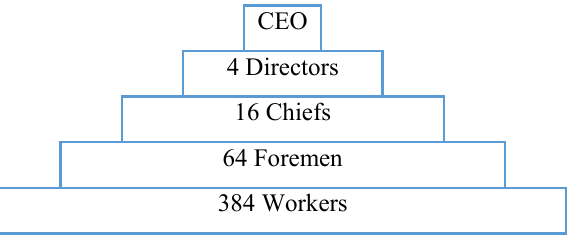
Figure 5: Example of an organization's hierarchical structure In this example, the total number of base workers ( T ) in the organization is 384, the total number workers w ( T ) is 468, excluding the top level of CEO.